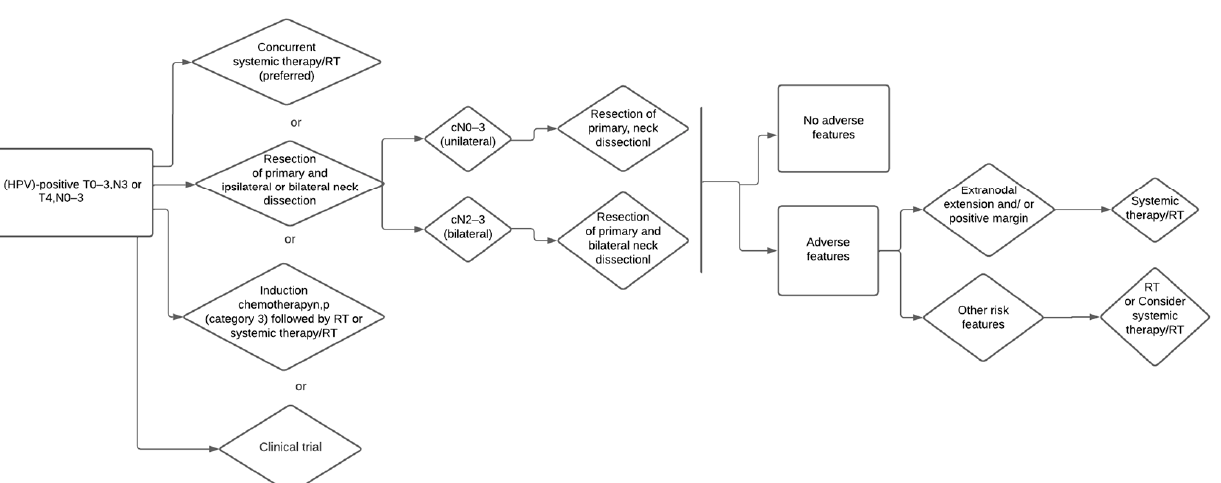
Figure 2. AJCC Decisional tree p-16 negative, T3-T4a N0-1 or T1-4 N2-3. The surgical techniques applied in advanced OPSCC stages have also changed over time [45]. Initially, open techniques were the primary surgical choice [46]. However, inva- sive approaches such as mandibulotomy or trans-cervical pharyngotomy resulted in se- vere functional and aesthetic morbidity [47]. Recently, trans-oral surgical techniques have been introduced, reporting excellent functional outcomes without compromising the oncological outcomes, when compared to open surgical procedures [48–50]. The introduction of laser CO 2 and transoral robotic sur- gery (TORS) approaches resulted as new and remarkable alternatives to chemoradiother- apy, especially in stage I and II oropharyngeal carcinomas, [51]. Furthermore, an aware- ness of better survival patterns amongst HPV-related OPSCC patients boosted interest in systemic treatment de-escalation following mini-invasive trans-oral techniques [52]. However, literature data on trans-oral surgery in advanced stages is limited, due to diffi- cult cancer exposure and possible insufficient surgical radicality with positive resection margins [53–55]. Trans-oral surgery is not free of complications, especially if there is involvement of the internal carotid artery, or both lingual arteries [56]. Limited mouth opening does not